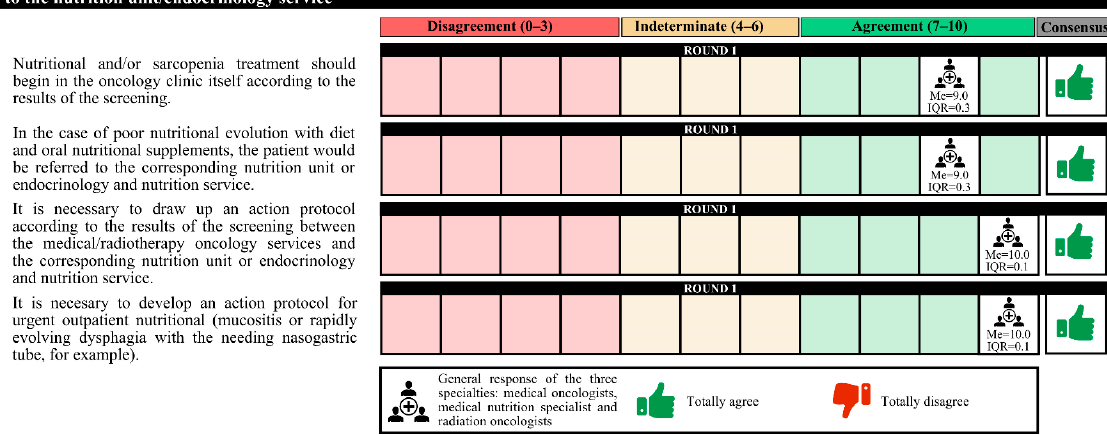
Figure 10. Answers on patient referral and multidisciplinary care. IQR, interquartile range; Me, median.